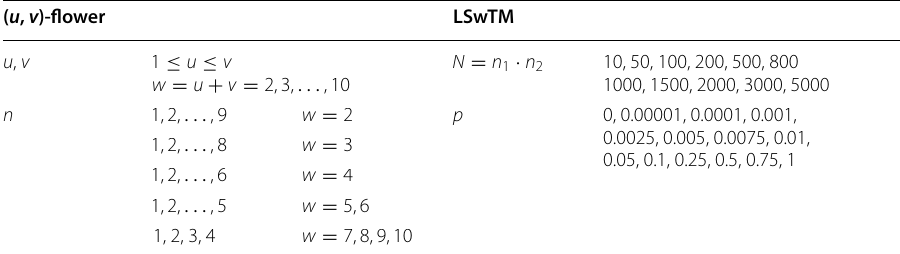
Table 2 Parameter settings for the ( u , v )‑flower and the Lattice small‑world transition model, with which the analyzed networks were generated. n denotes the number of iterations, for the meaning of the other parameters, see the Network models section. In the case of the LSwTM, the values of the n 1 , n 2 parameters are chosen in such a way that | n 1 − n 2 | is minimal. The resulting number of networks: 118 (( u , v )‑flower), 154